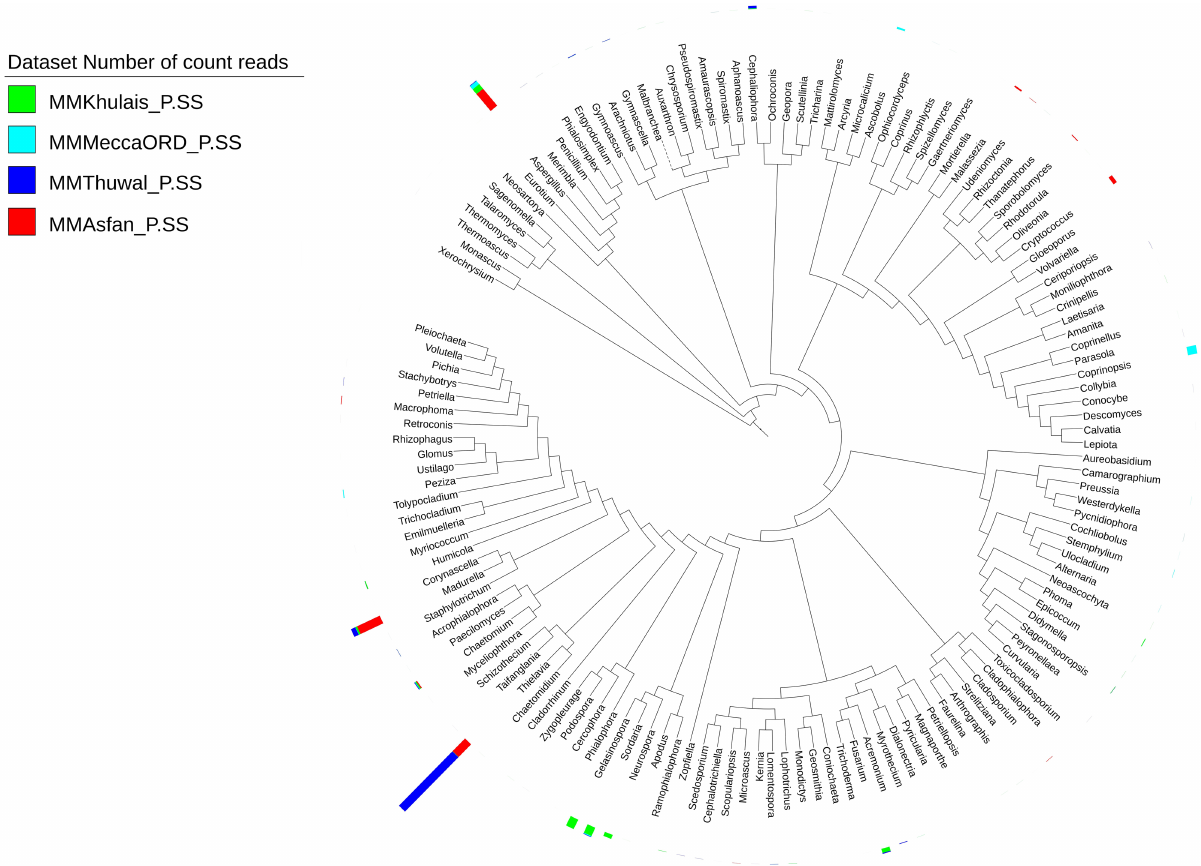
Fig 4. Hierarchical tree representing taxonomic relationships of fungal genera detected in all four sites of Meccaregion, Saudi Arabia. The height of the bars in the circle outsidethe branch tips correspondsto the number of reads within genera.The key to bar color for the samples are at the top